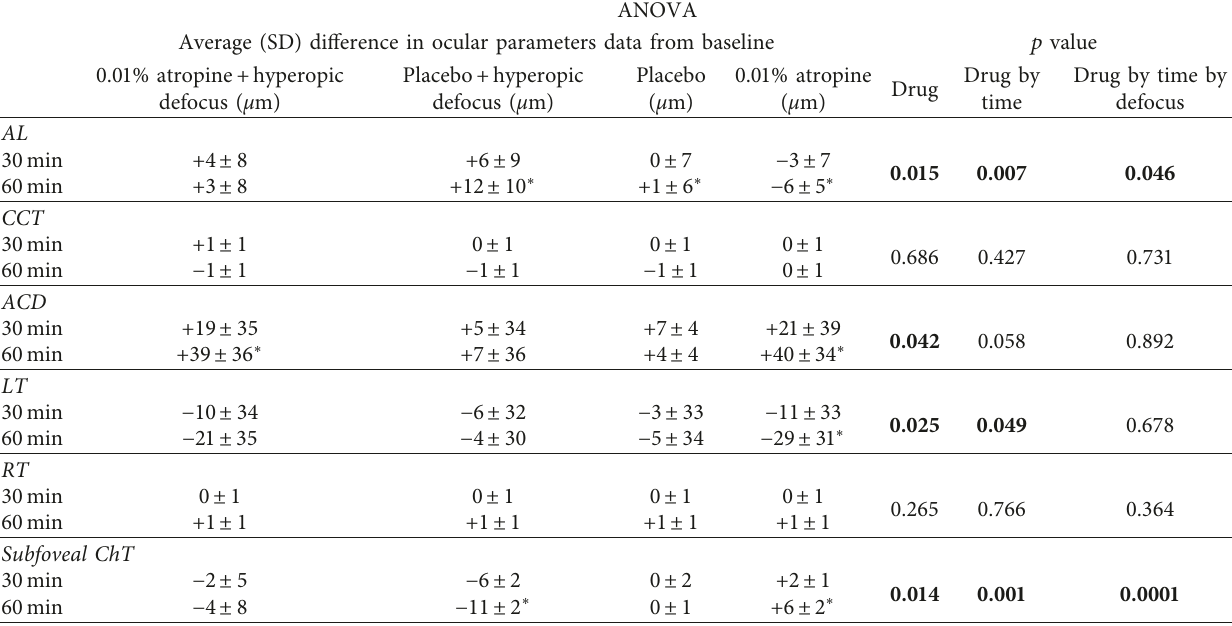
Table 2: Effects of 0.01% atropine and placebo with or without hyperopic defocus on the average change in ocular variables at 30 and 60minutes from baseline. ANOVA Average (SD) difference in ocular parameters data from baseline p value 0.01% atropine